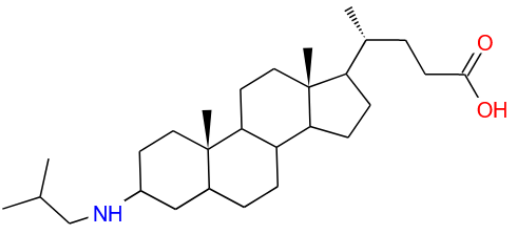
Figure 1. 3-(isobutylamino)cholan-24-oic acid (AMS).